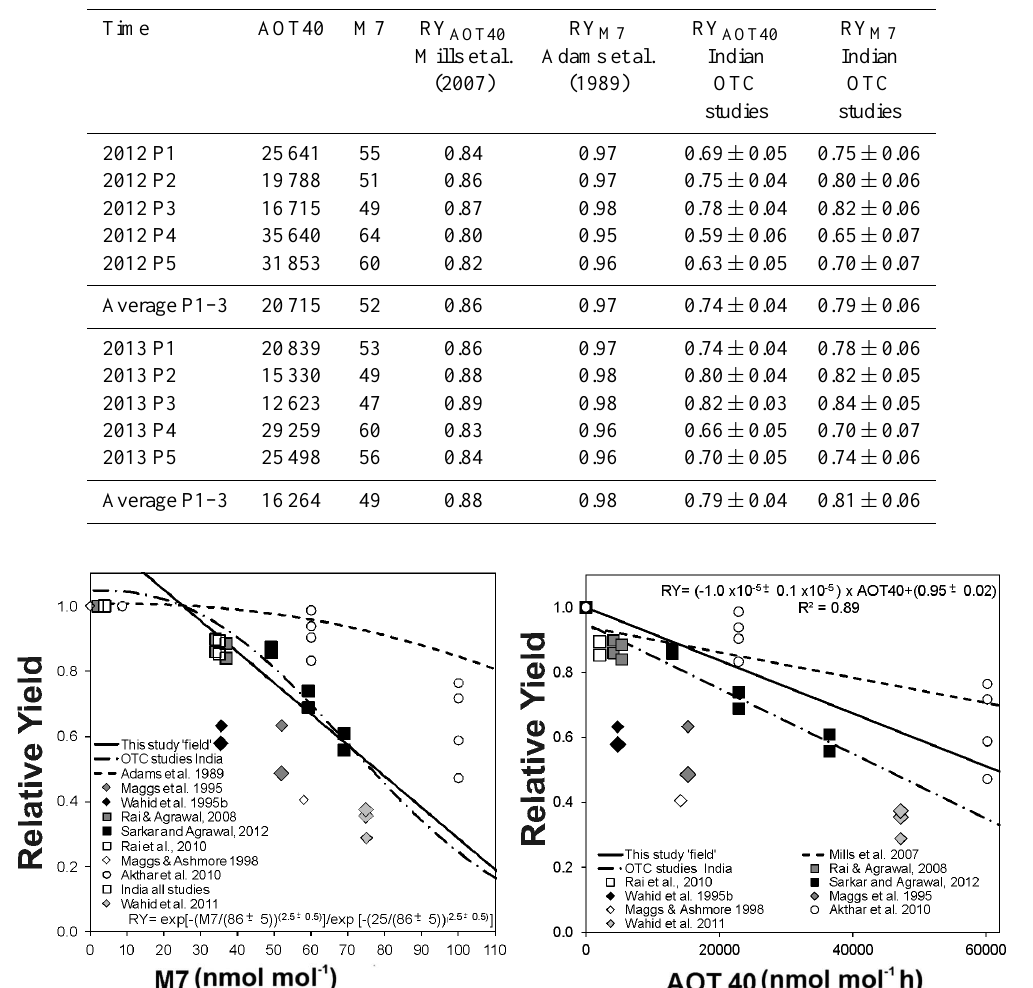
Table 5. Ozone exposure according to different exposure indices and relative yields for rice. Data for the five periods used to plot Fig. 3 are provided in the table. Periods (P) 1–3 correspond to the periods in which rice is usually grown in Punjab and Haryana, and the average yield loss of these three periods is used to calculate crop production loss and economic loss for each fiscal year.